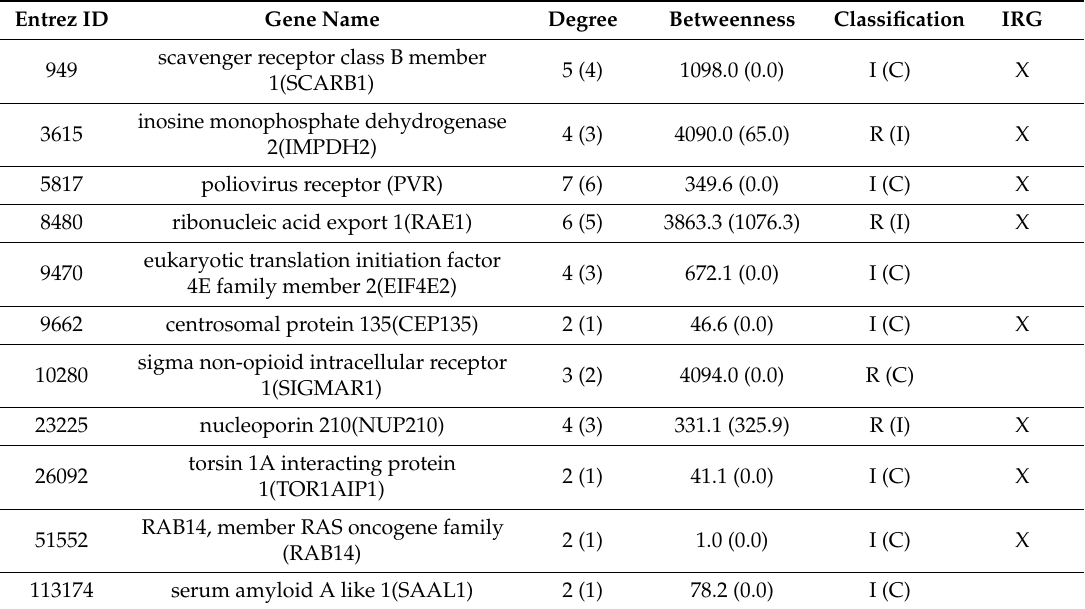
Table 5. The identities and topological characteristics of the proteins identified in the global controllability analysis. Values for degree, betweenness, and classification are given as VIN (HIN). Classification is denoted as indispensable, I; neutral, N; and dispensable, D. Genes which have experimentally shown a fold change in expression greater than 2 during interferon knockdown studies are denoted as interferon regulated genes